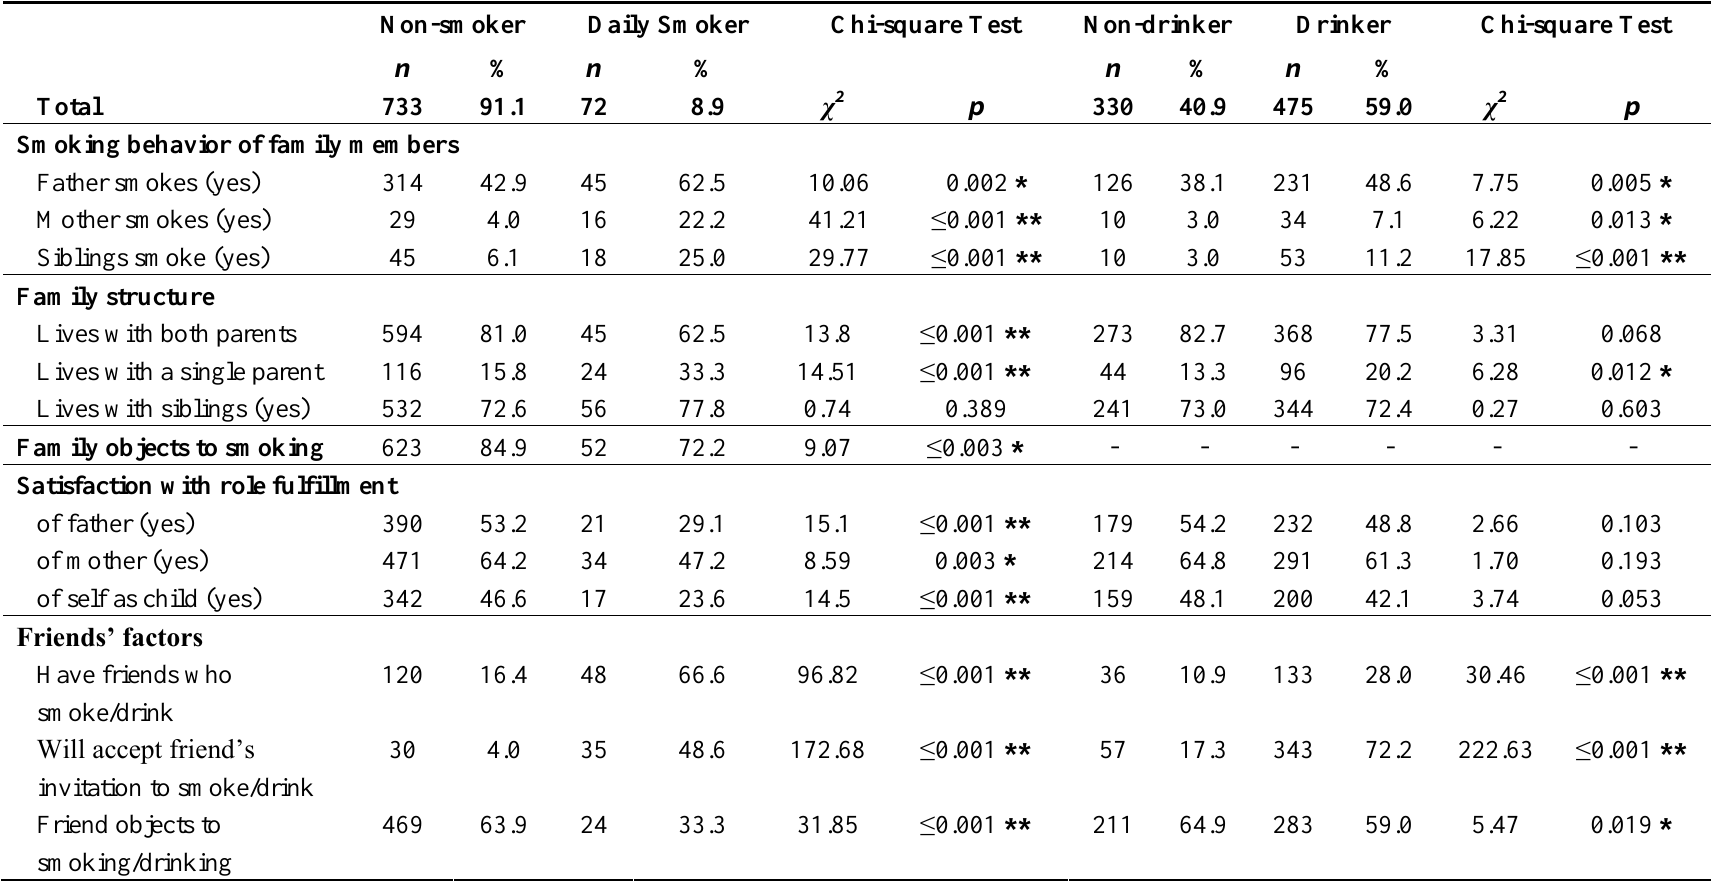
Table 2. Comparison of smoking behaviors of family members, family structure, satisfaction of roles, and friends‘ factors between adolescents with and without risk behaviors ( n = 805). Non-smoker Daily Smoker Chi-square Test Non-drinker Drinker Chi-square